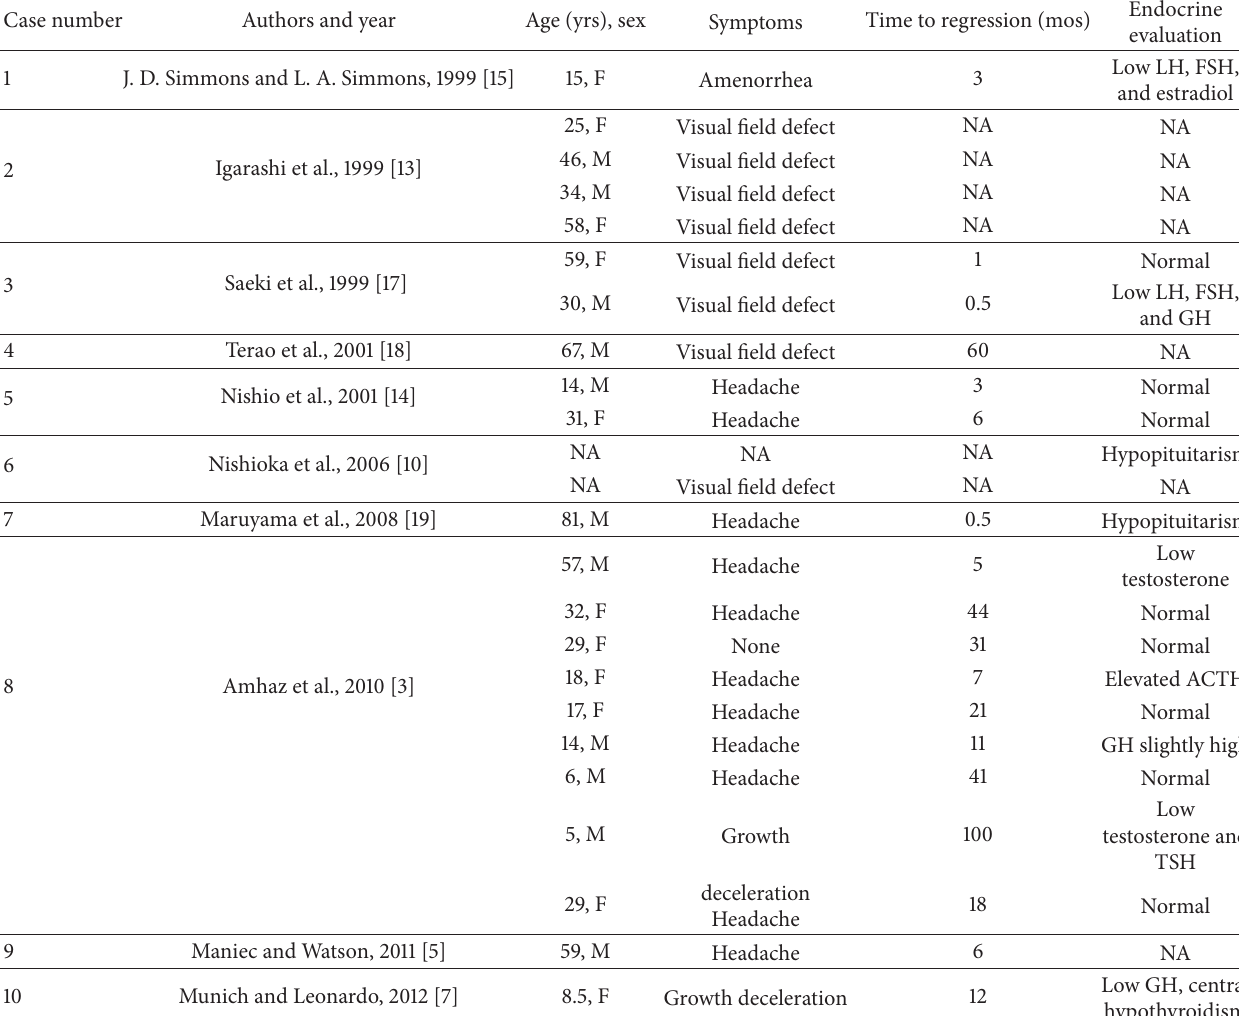
Table 1: Reported cases of spontaneous regression of